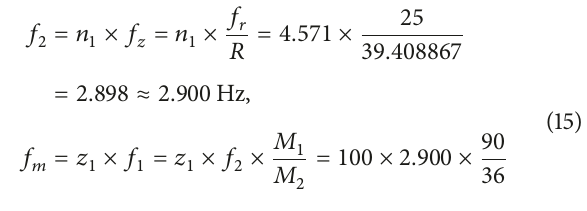
Table 3: Experimental parameter table. Experimental parameters